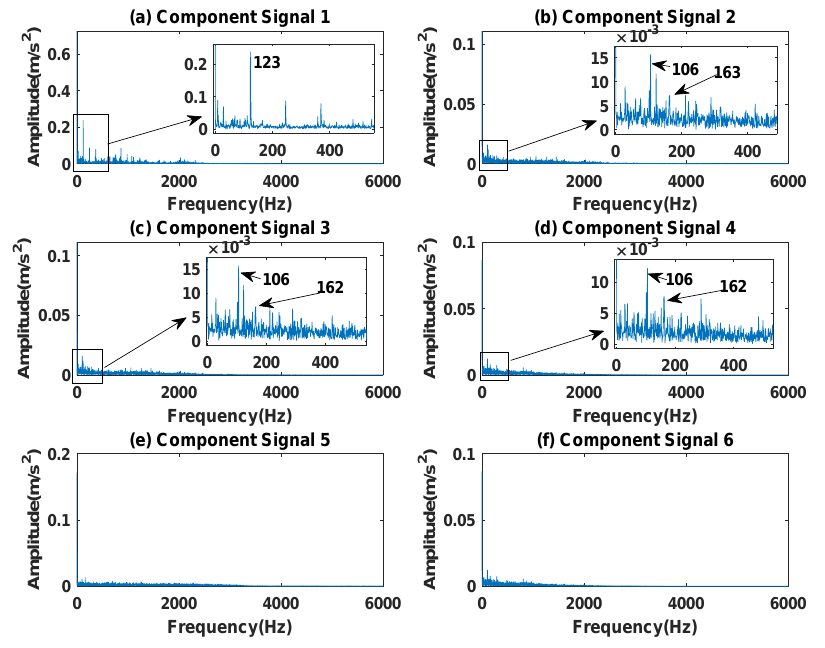
Figure 24. Decomposition results of SVDP with m = 16 and J = 3: ( a – f ) envelop of 1st to 6th subcomponents, respectively.